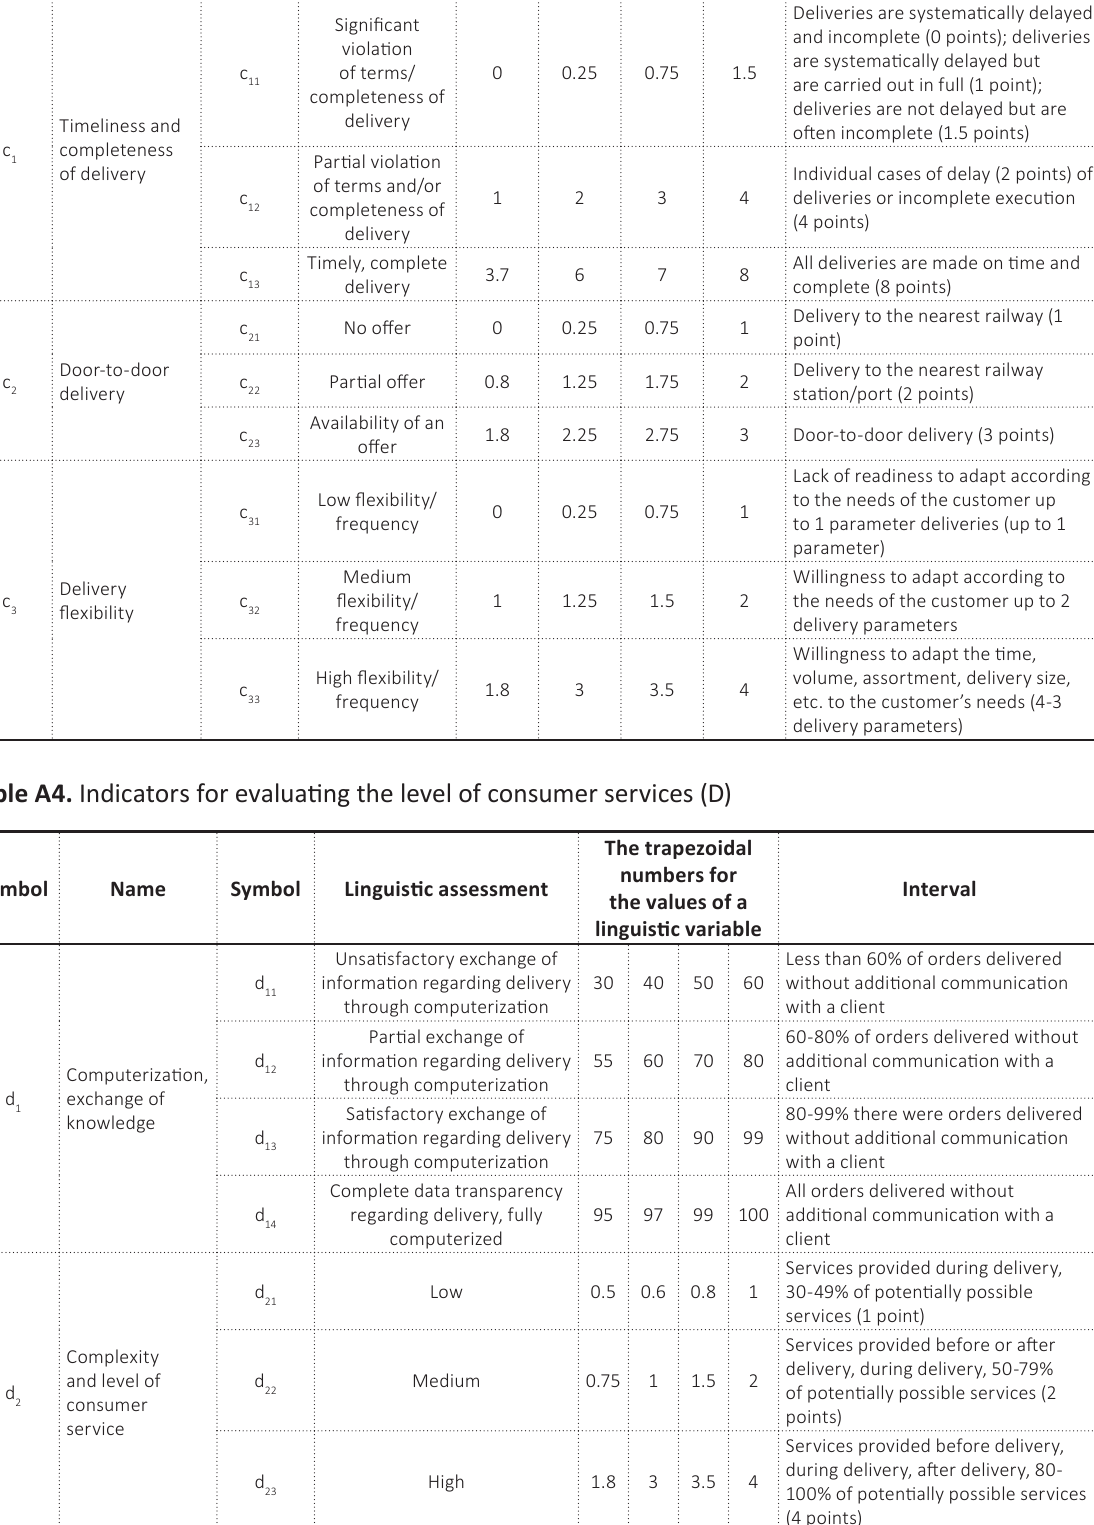
Table A3. Indicators of reliability/flexibility (C) Symbol